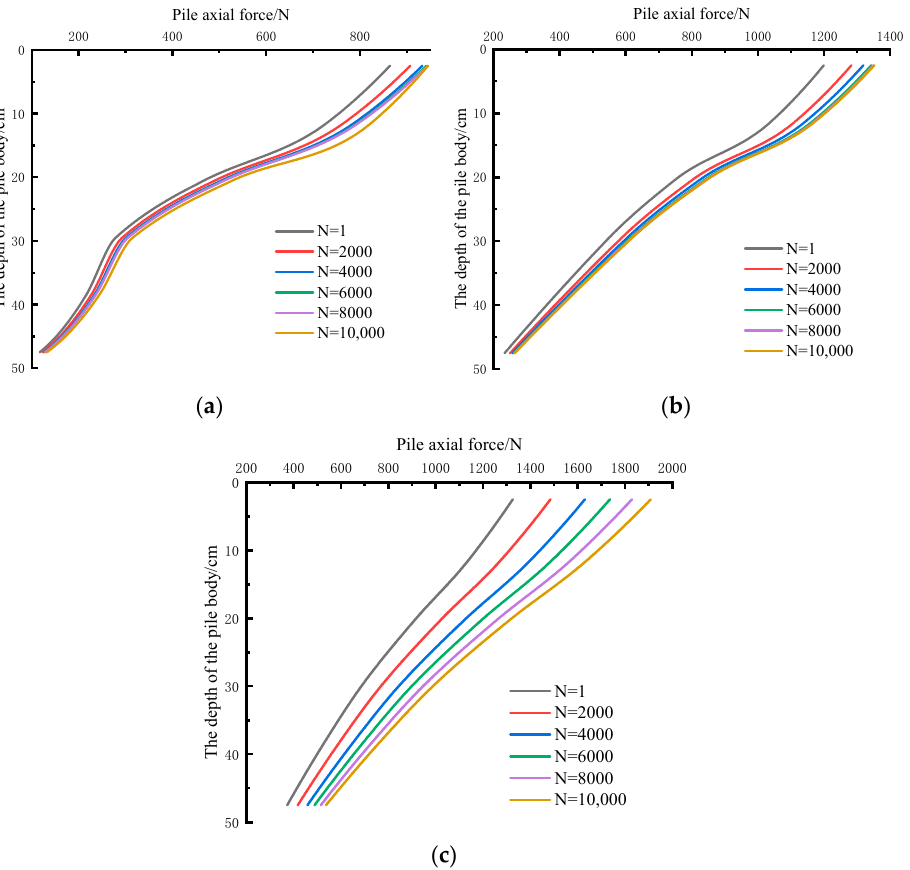
Figure 9. The axial force of the pile under cyclic load changes with the number of cycles. ( a ) M = 0.2; ( b ) M = 0.4; ( c ) M =